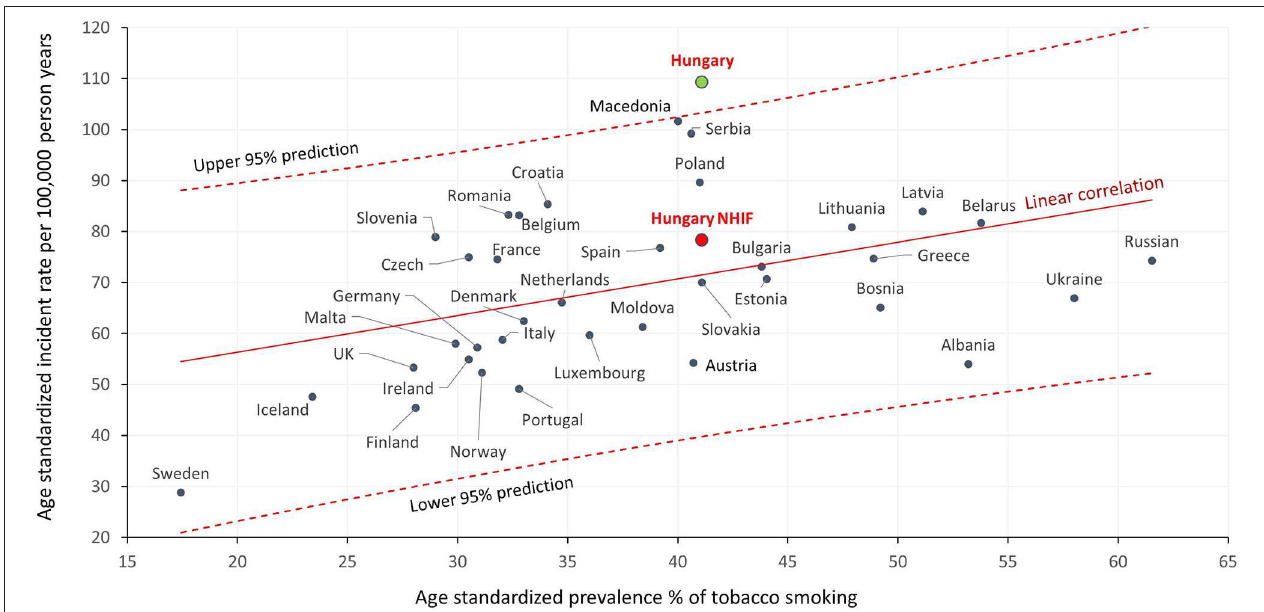
FIGURE 4 | Correlation between the age-standardized incidence rate of lung cancer in European countries in 2012 based on the report by Ferlay et al. (2) and the age-standardized prevalence (%) of tobacco smoking in the population aged ≥ 15 years in 1998–2002. Description: incidence rates of lung cancer are presented as a function of the prevalence of tobacco smoking. The X axis represents the age-standardized prevalence of smoking expressed in percentages in the population aged > 15 years between 1998 and 2002 and the Y axis represents the age-standardized incidence rates of different European countries, thus merging these data in one